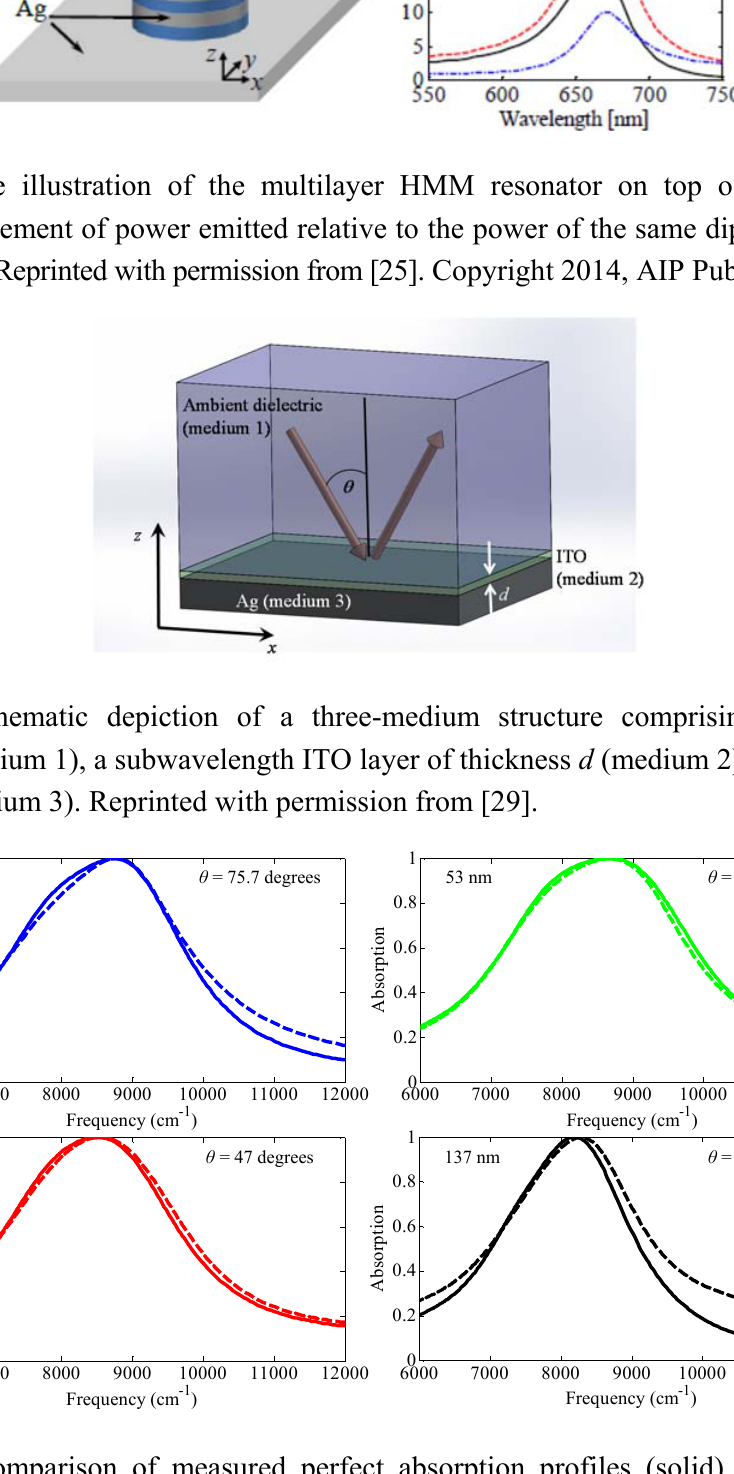
Figure 10. Comparison of measured perfect absorption profiles (solid) and calculated profiles using the three-medium Fresnel equation (dashed) for the four samples. The perfect absorption (PA) angle is explicitly indicated in each subplot. Reprinted with permission from